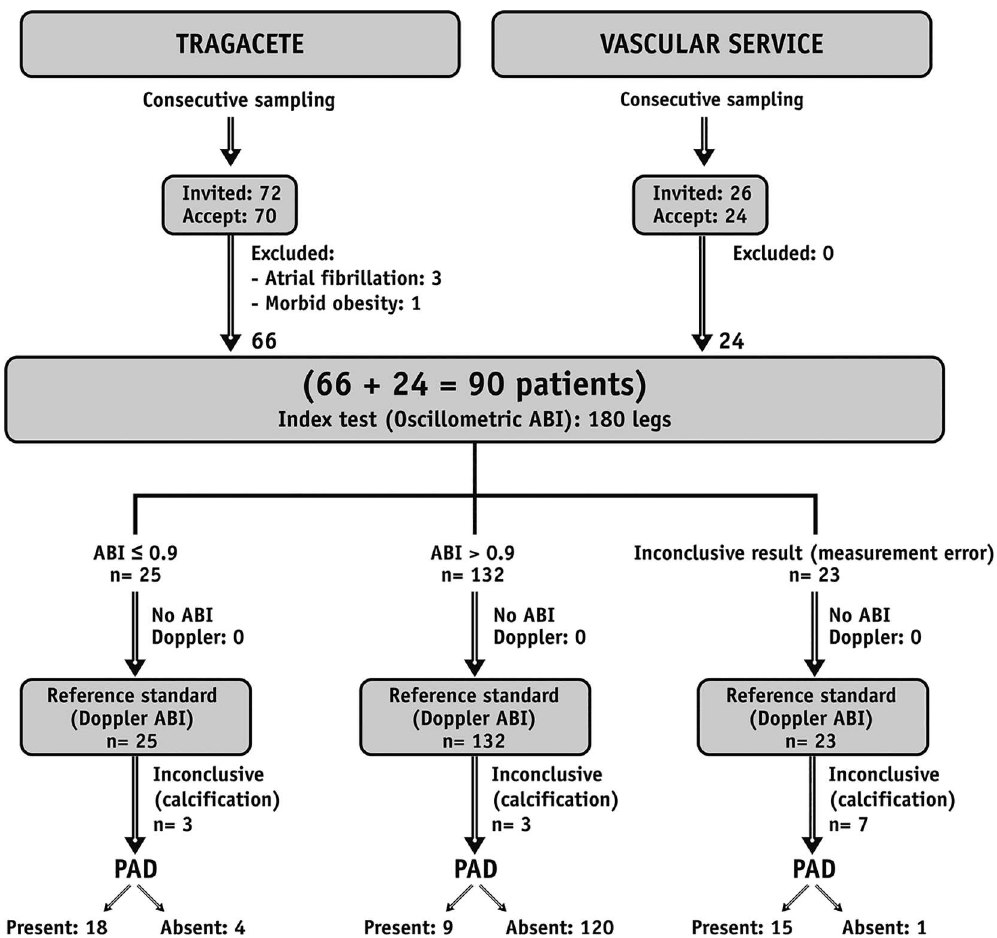
Fig 1. Flow chart of the study. Study design,number of participants and results of the measurements according to STARD [16] standards.